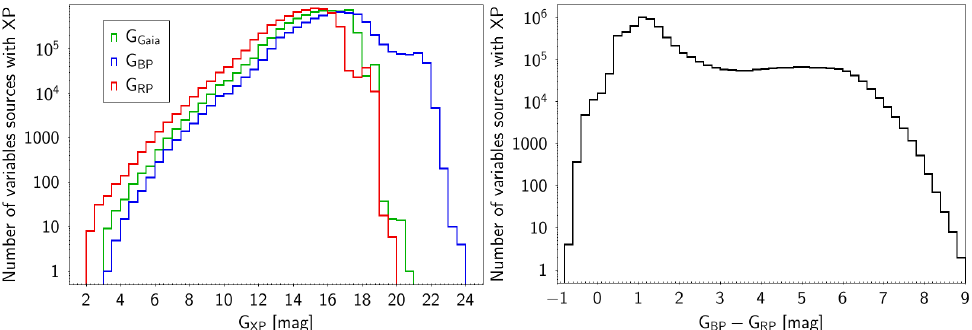
Figure 3. G Gaia magnitude ( left ) and G BP − G RP ( right ) histograms for sources with phot_variable_- flag=’VARIABLE’ (excluded from our study) with continuous XP spectra in Gaia